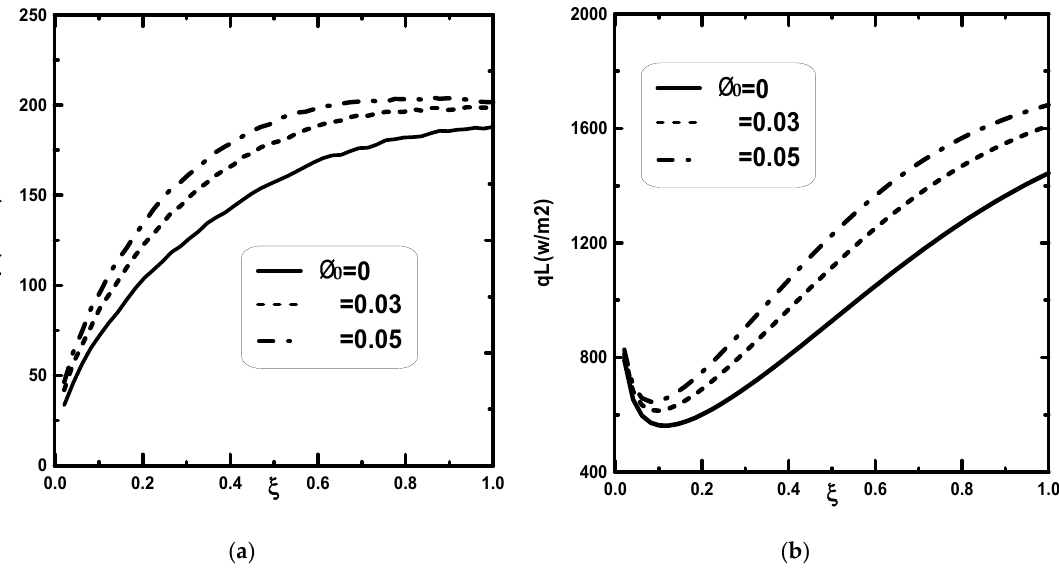
Figure 10. Impact of φ 0 on the sensible qs ( a ) and latent ql heat fluxes ( b ): T 0L = 293.15 K, T 0 = 293.15 K, q 1 = 3000 W/m 2 , T w = 293.15 K, c 0 = 0, u 0 = 1 m/s, m 0L = 15 × 10 − 4 Kg/m.s, H = 1 m, d = 0.015 m, p 0 = 1 atm.